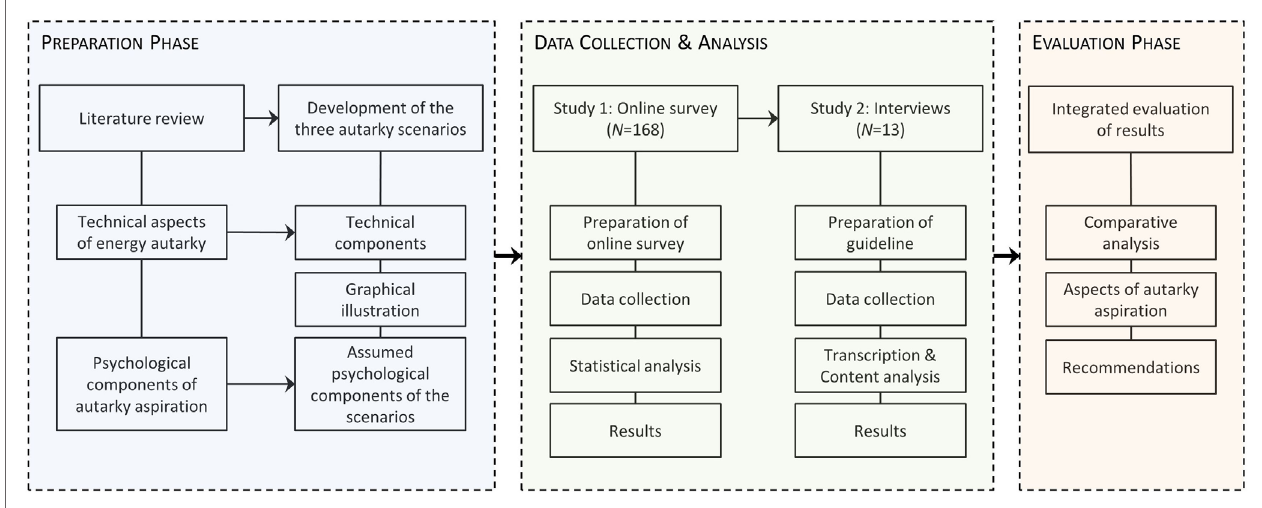
FigUre 1 | Schematic overview over methodological